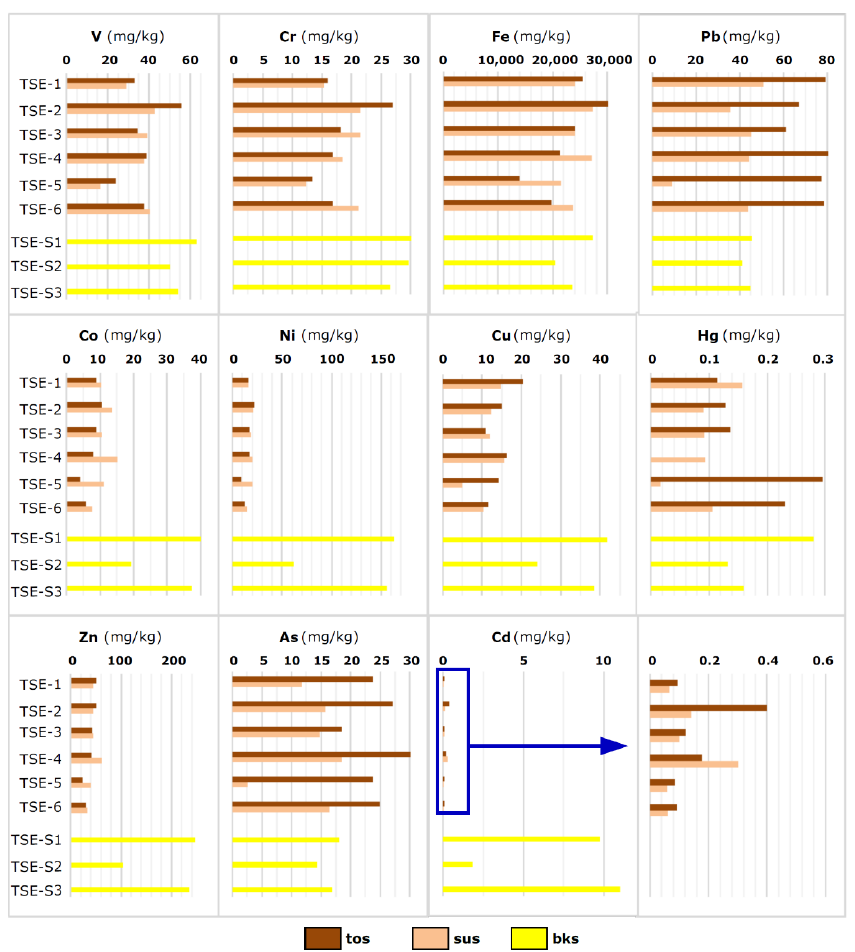
LOI) and the concentrations (mg/kg) of Cd, Co, Ni, Zn and As in reservoir sediments, exemplarily shown by the sediment cores ES−S, ES−II and ES−I.